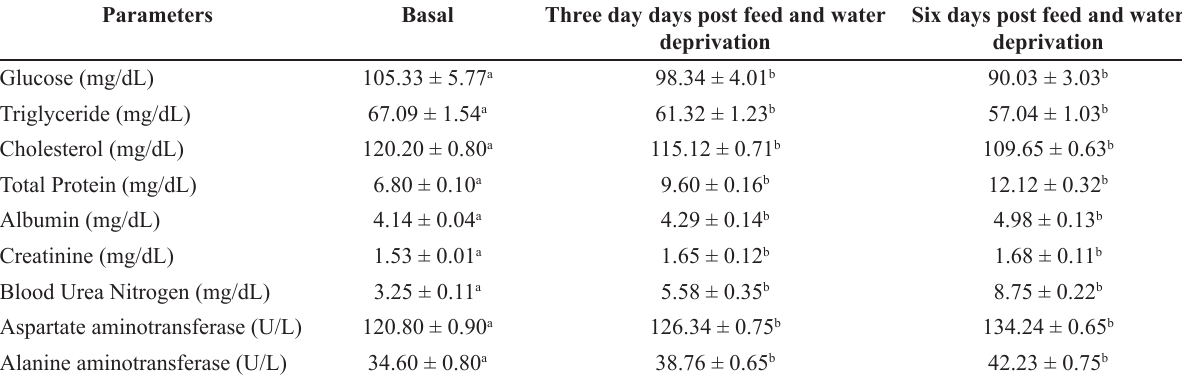
Six days post feed and water deprivation